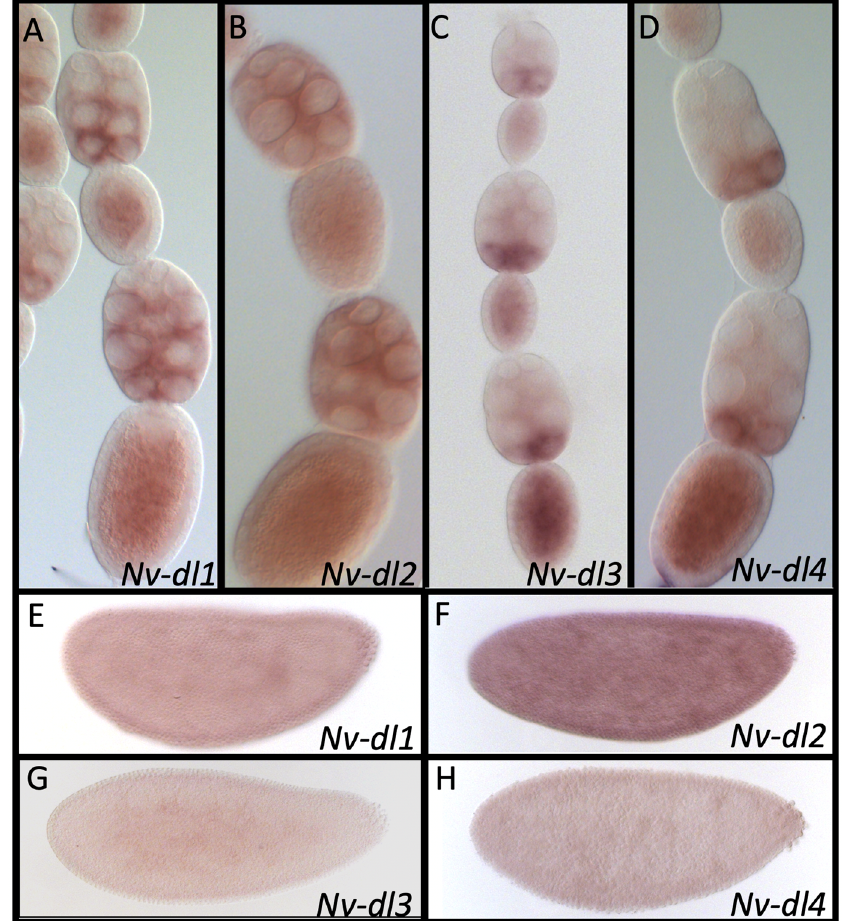
Figure 9. mRNA expression of dorsal paralogs in N. vitrpennis ovarioles and embryos. ( A ) Nv-dl1 is expressed ubiquitously in the oocyte and most of the nurse cells, except for the most anterior ones (mid to late oogenesis shown) ( B ) Nv-dl2 is ubiquitously expressed in the oocyte and nurse cells. ( C ) Nv-dl3 is ubiquitously expressed in the oocyte, and is strongly upregulated in the posterior of the nurse cells (early to mid stages shown). ( D ) Nv-dl4 is expressed in the oocyte and the nurse cells, with expression concentrated in posterior nurse cells (mid to late stages shown). Nv-dl1 ( E ), Nv-dl2 ( F ), Nv-dl3 ( G ), and Nv-dl4 ( H ) are ubiquitously expressed in the embryo (early blastoderm stages shown). Anterior is at the top for ovaries and to the left for embryos.